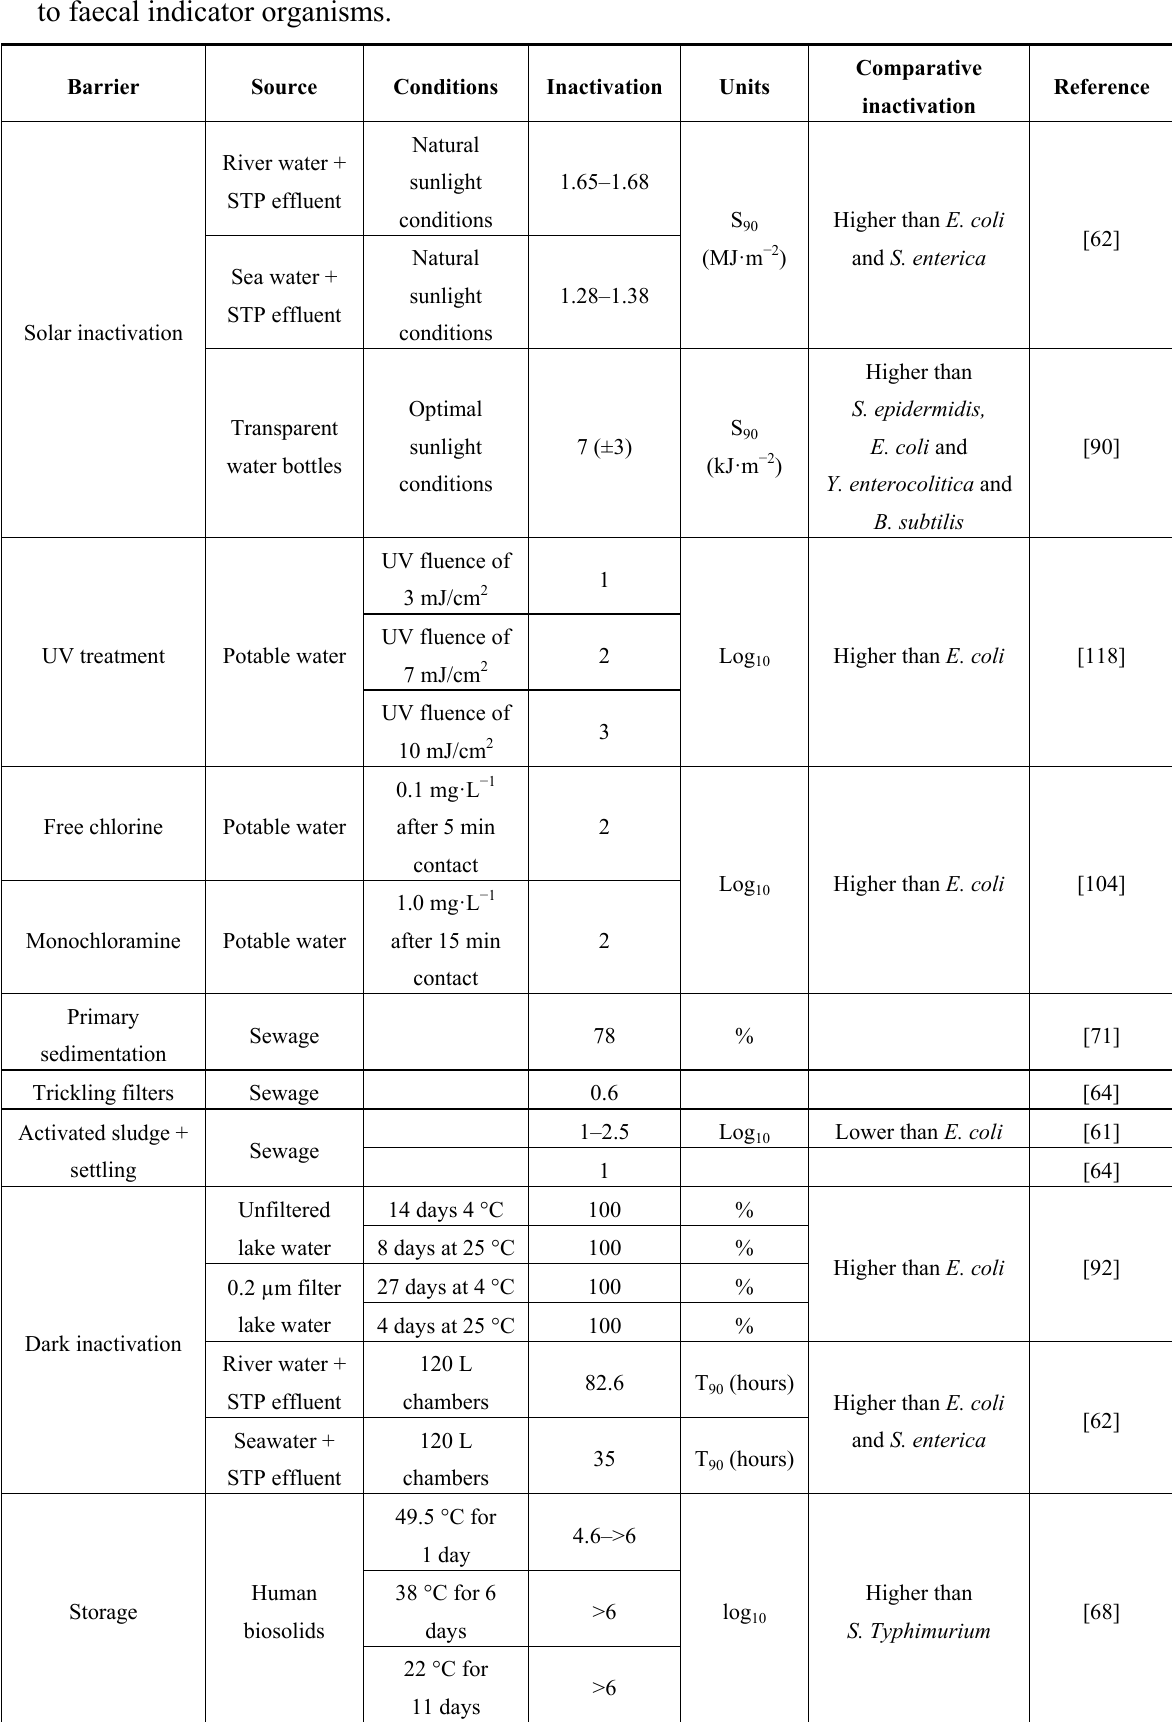
Table 2. Campylobacter inactivation by environmental and treatment processes compared to faecal indicator